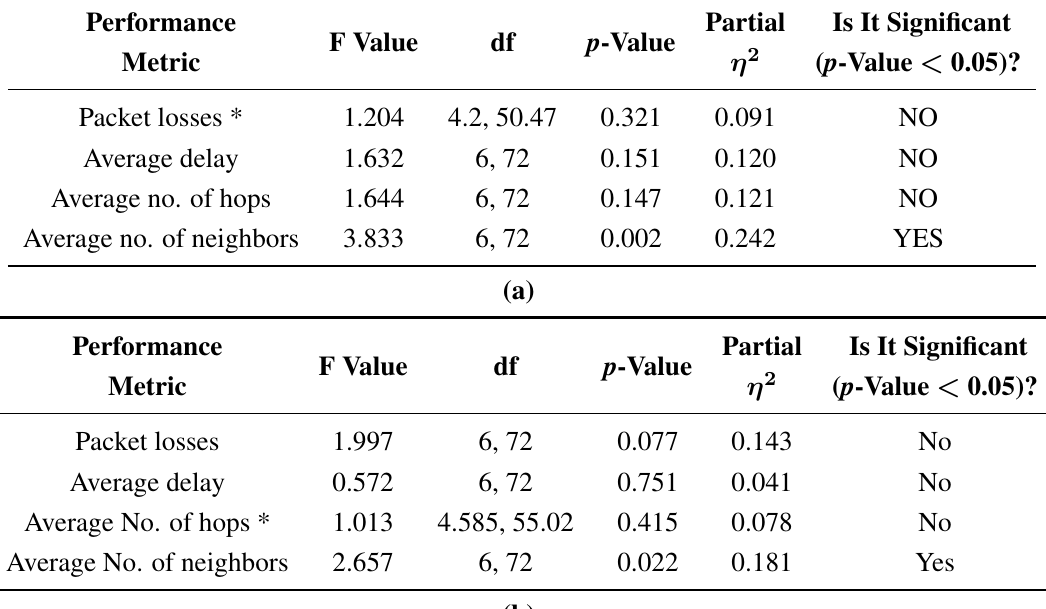
Table 2. p -Values from Mixed Analysis of Variance (ANOVA) test for the relation between the attenuation model and vehicle density. ( a ) Barcelona scenario. 1 AP. Uniformly distributed traffic; ( b ) Tarragona scenario. 6 APs. Exponentially distributed